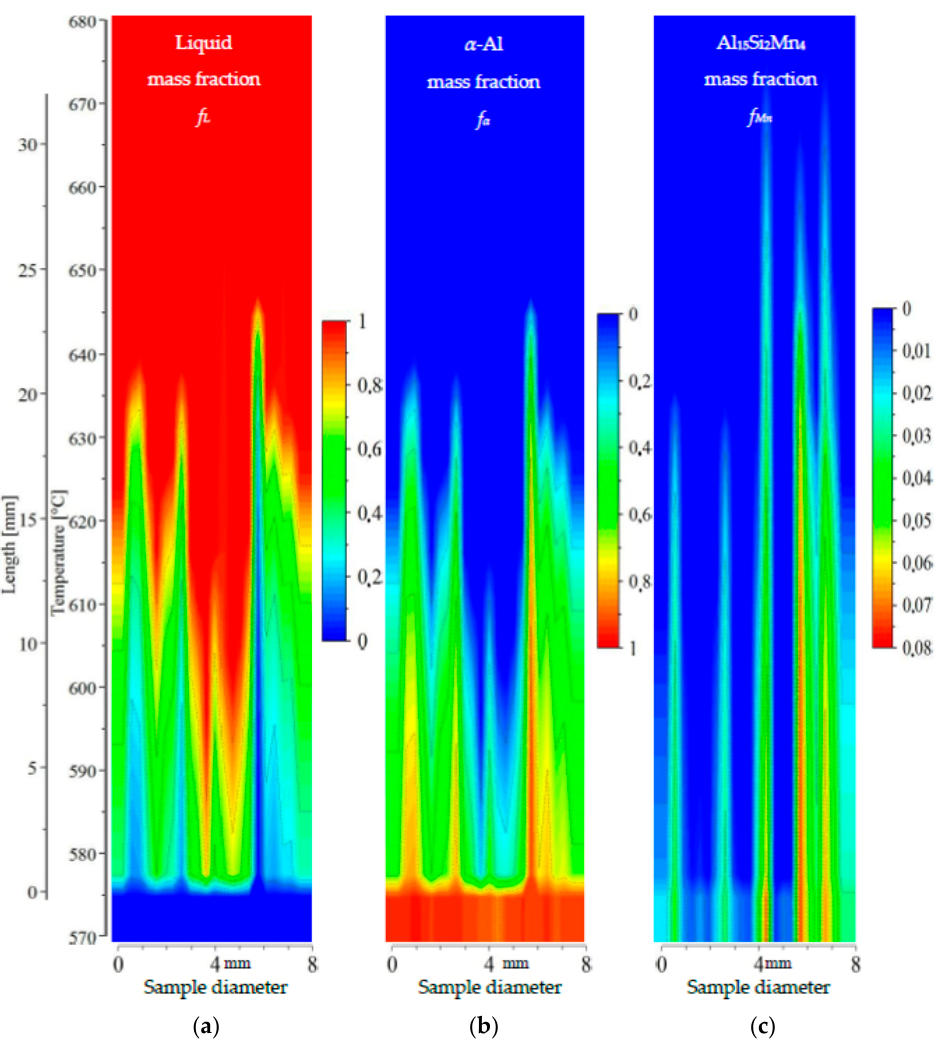
Figure 11. 2D maps of mushy zone for AlSi5Mn1.0 specimen: ( a ) liquid mass fraction f L ; ( b ) α -Al mass fraction f α ; ( c ) Al 15 Si 2 Mn 4 mass fraction f Mn in function of sample diameter and temperature/sample length.